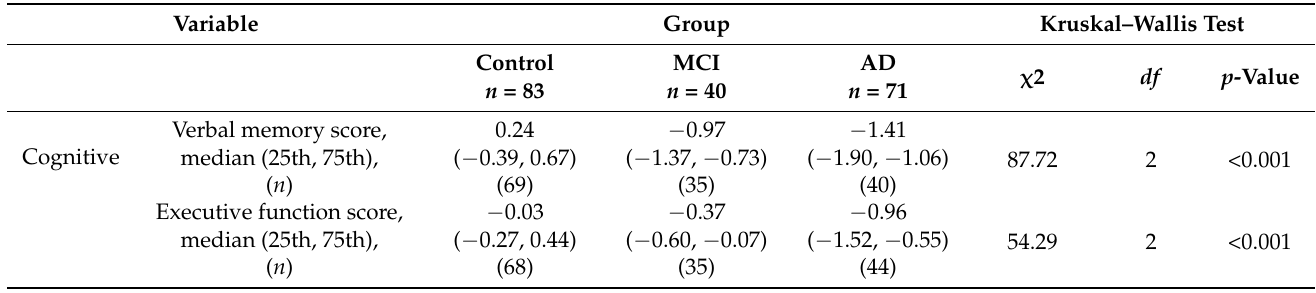
Table 3. Cognitive, functional, and magnetic resonance imaging scores across the